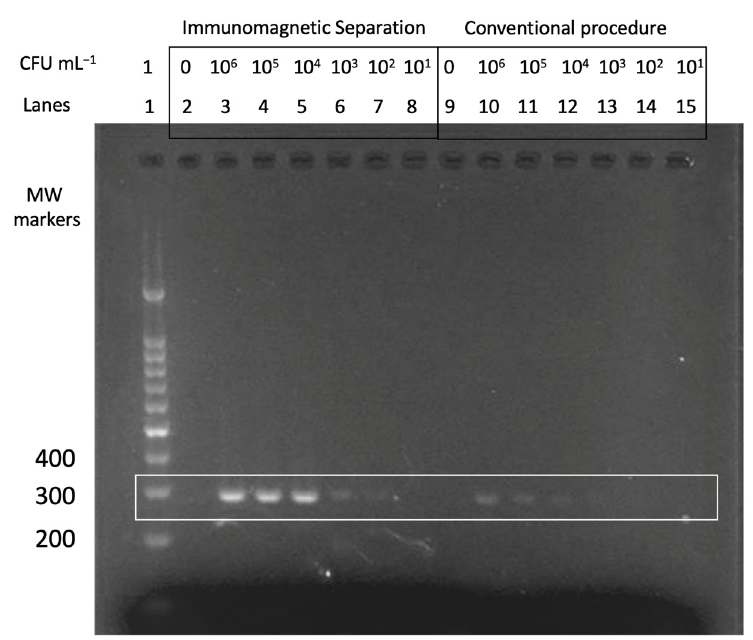
Figure 5. Gel electrophoresis. Lane 1 is the molecular weight (MW) marker. Lanes 2 to 8 were obtained by the double tagging PCR combined with IMS. Lane 2 is the negative control of this procedure and corresponds to 0 CFU mL − 1 . Lanes 3 to 8 range from 10 6 to 10 1 CFU mL − 1 . Lanes 9 to 15 are the samples resulting from the double tagging PCR obtained by conventional DNA extraction, instead of IMS, from 10 6 to 10 1 CFU mL − 1 (lanes 10 to 15). Lane 9 is the negative control of this procedure and correspond to 0 CFU mL − 1 .